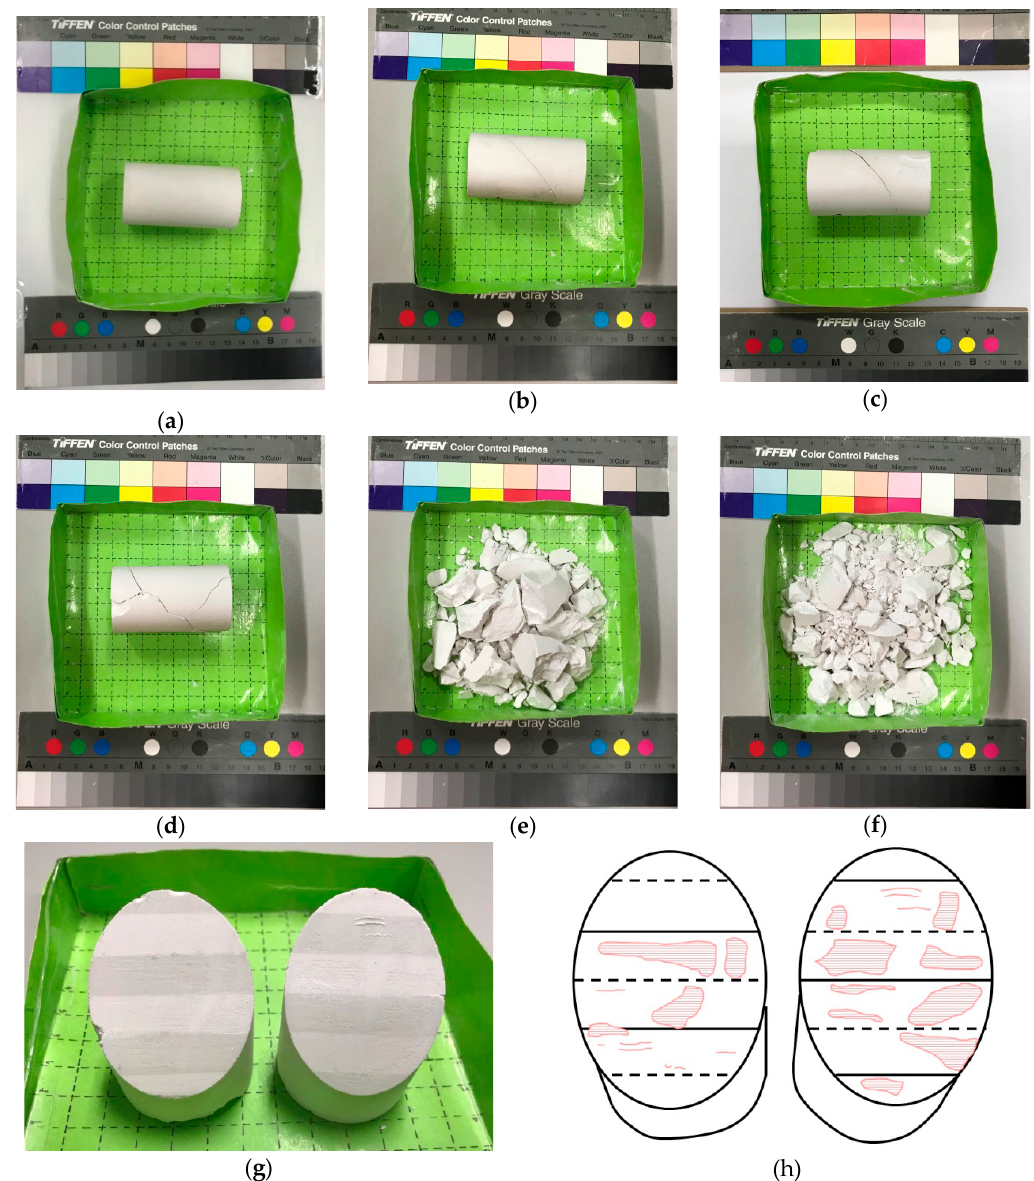
Figure 5. Images of specimen after the SHPB test: ( a ) integrated without any flaking of intact specimen, ( b ) two parts of specimen, with β = 39 ◦ and α = 0 ◦ slide relative to each other, without any tiny flakes, ( c ) two parts of specimen, with β = 51 ◦ and α = 3 ◦ slide relative to each other, with tiny flakes on both parts, ( d ) fractured specimen, with β = 39 ◦ and α = 18 ◦ , break along concave part of sawteeth can be observed, ( e ) completely fractured specimen, with β = 45 ◦ and α = 15 ◦ , ( f ) crushed jointed specimen, ( g ) scratches on joint surface of specimen in ( c ), ( h ) depicting ( g ) with an emphasis on scratches on joint